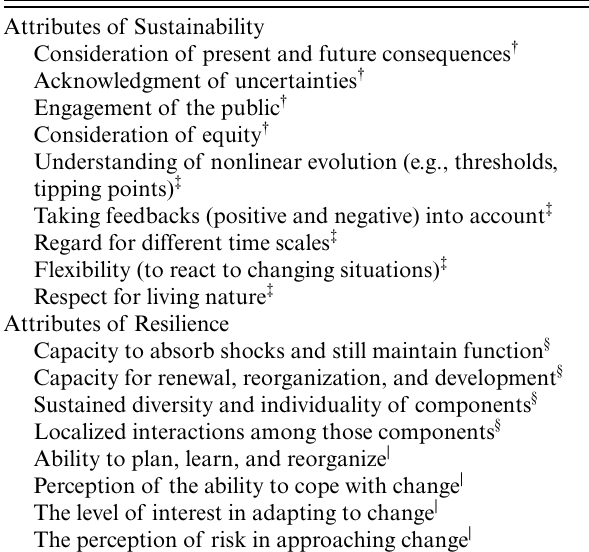
Table 1 . Attributes of sustainability and